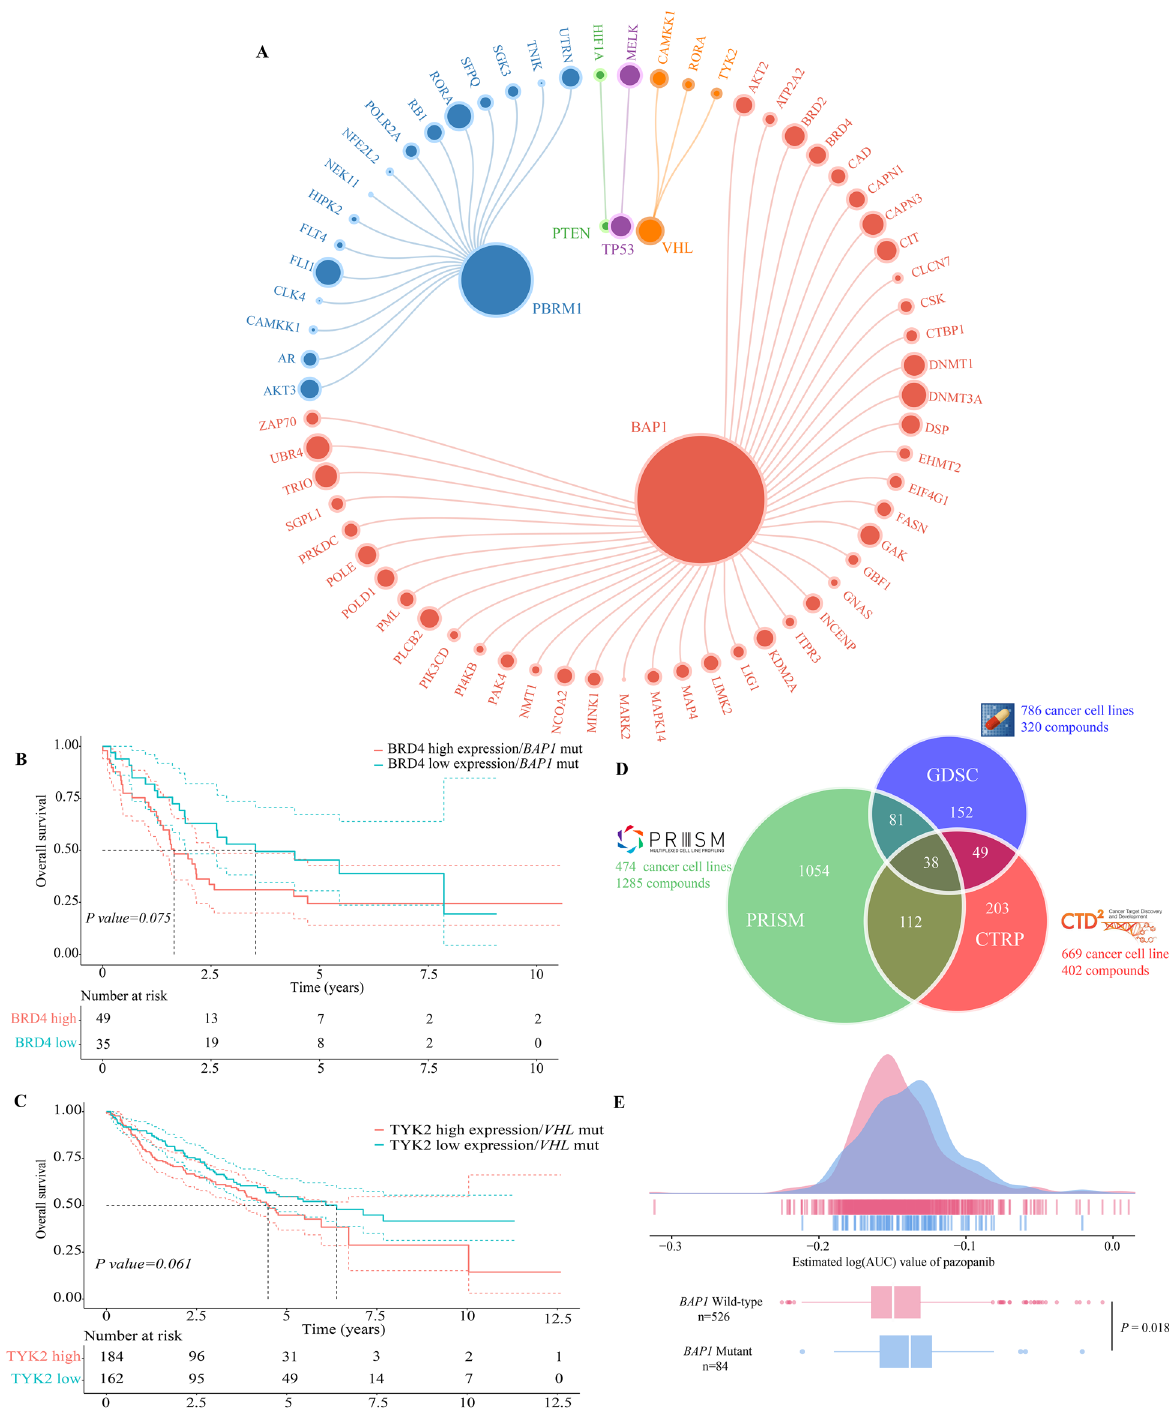
Figure 3. Exploring feasibility of druggable genes in treating driver mutation-specific clear cell renal cell carcinoma patients. ( A ) The bipartite network of representative DM-DG interactions. ( B ) Overall survival of distinct BRD4 expression profiles in BAP1 mutated patients. ( C ) Overall survival of distinct TYK2 expression profiles in VHL mutated patients. ( D ) The venn graph for summarizing the available cancer cell lines and compounds in CTRP, PRISM and GDSC pharmacogenomic datasets. ( E ) Comparing estimated drug sensitivity (LogAUC) of pazopanib between BAP1 mutated and wild-type